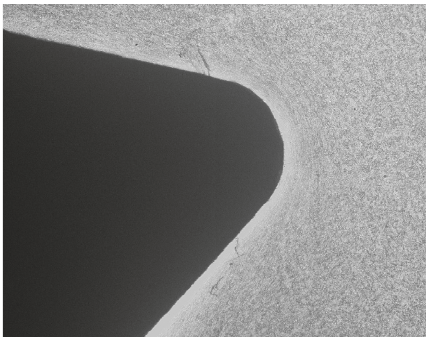
Figure 16: Micromorphology of carbon depletion at addendum and both tooth sides of the